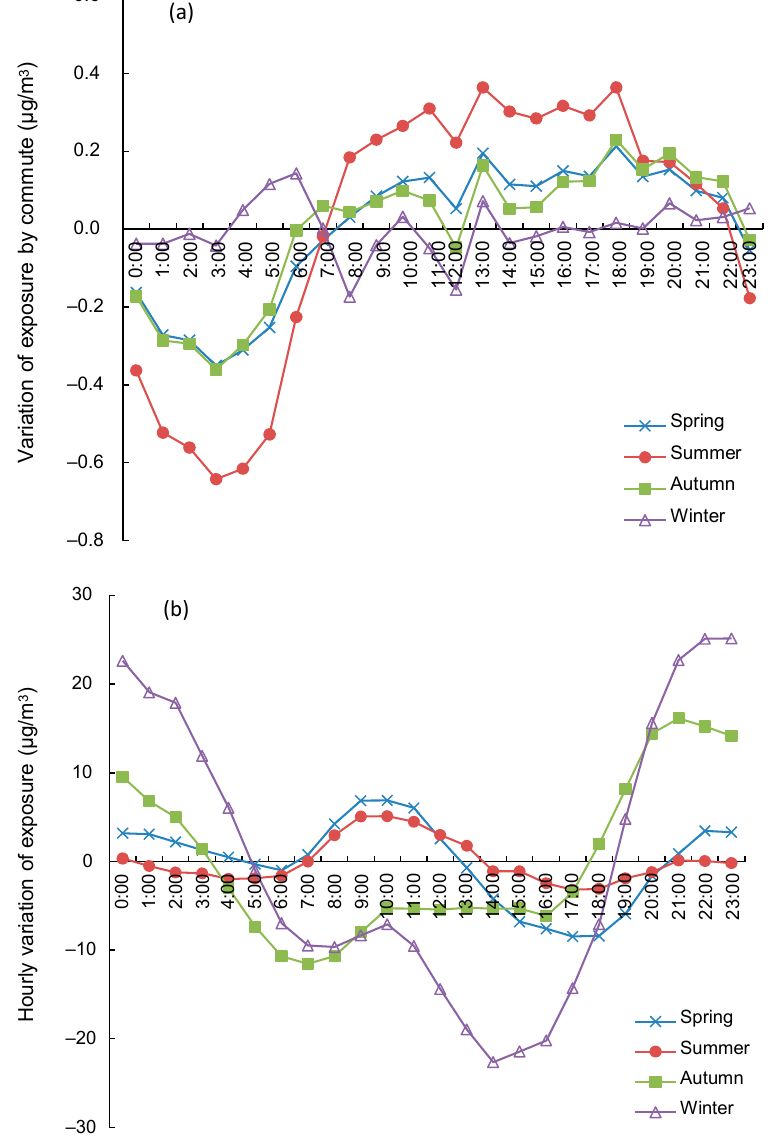
Figure 5. Hourly variation of PM 2.5 exposure for different seasons after subtracting their mean values. ( a ) the hourly variation of exposure solely caused by the commute of the population, ( b ) the hourly total variation of exposure caused by both the commute of population and the hourly change of PM 2.5 concentration.